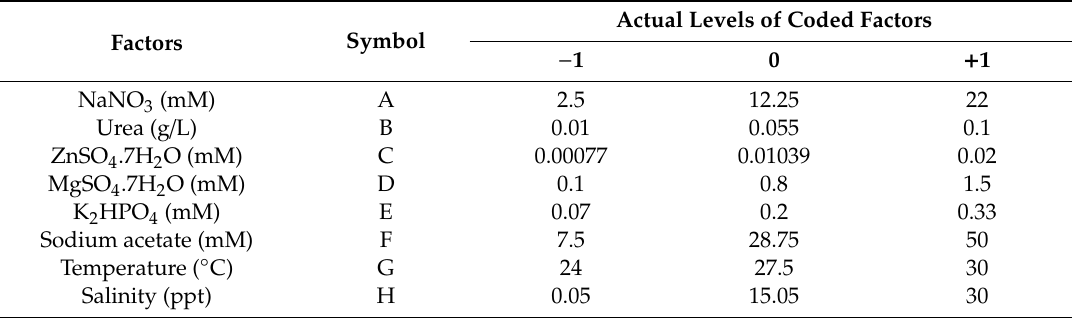
Table 8. Levels of factors used in Plackett–Burman